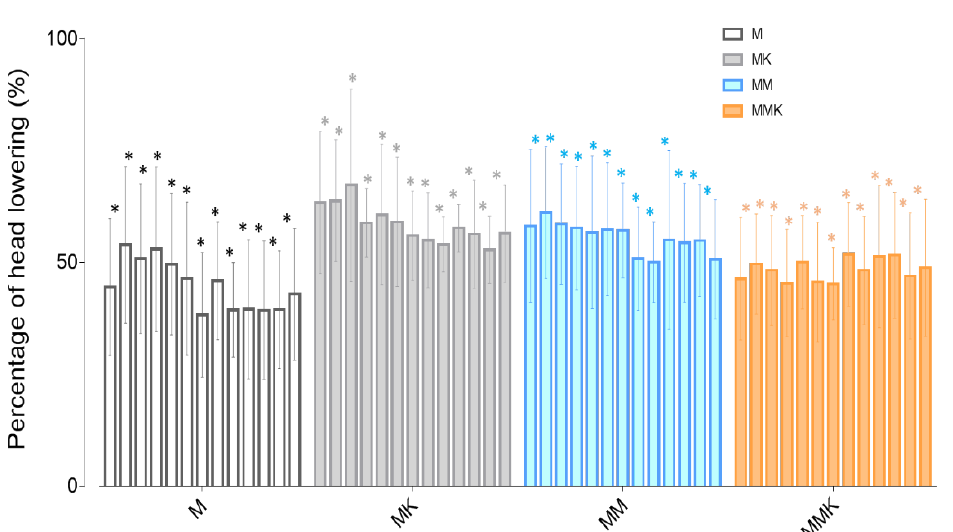
Figure 1. Percentage of head height to ground during the infusion every 10 min, with baseline as reference (100%) for sedation assessment. * Significantly different ( p < 0.05) from baseline within a treatment.